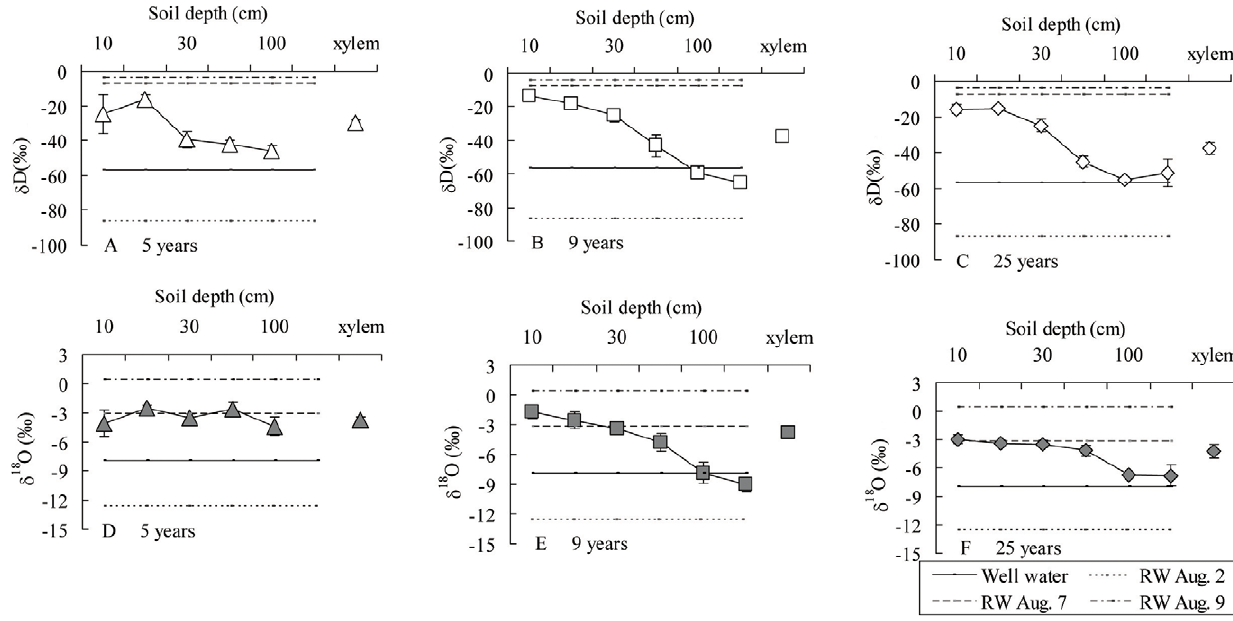
Figure 3. The d D and d 18 O ratio of Caraganaintermedia xylem water, different depths of soil water and rain water (mean ± SE). RW means rain water. Four replicates of xylem or soil sample was take in each age of C. intermedia plantations. Three replicates of rain water was take after each rainfall.